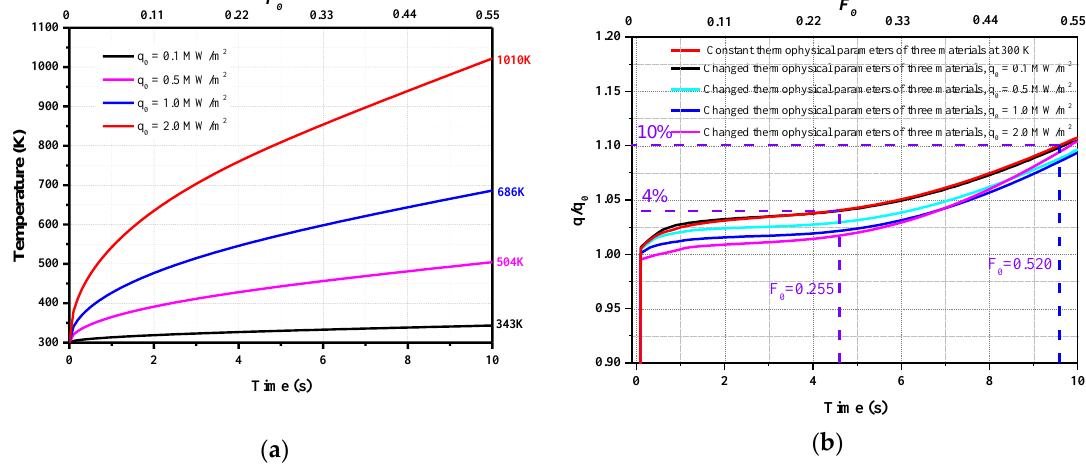
Figure 12. The calculated results for different loaded heat flux values: ( a ) Temperature; ( b ) Calculated heat flux using the thermal effusivity of chromel that changes with the surface temperature.